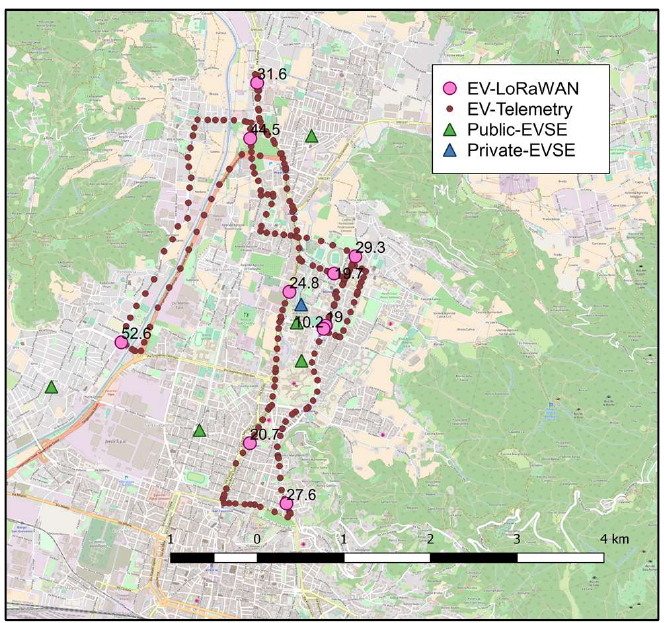
Figure 13. The georeferenced average speed (km/h) of the EV. The pink circles represent the value of the average speed of the EV estimated from the geographical coordinates transmitted to the LoRaWAN infrastructure every 5 min, while the red circles represent the speed of the EV recorded by the on-board telemetry system every 1 s. The experiment was carried out in the city of Brescia, north part of Italy. EV: Electric Vehicle, EVSE: EV Supply Equipment.